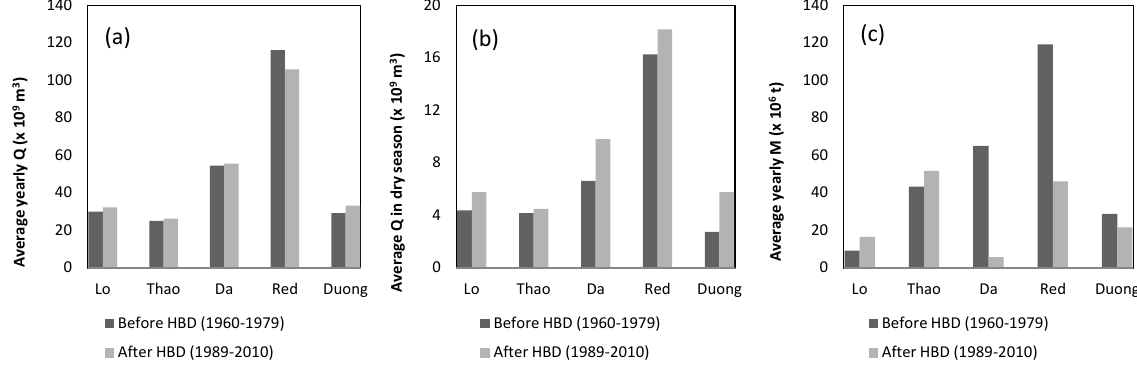
Figure 5. Change in average water and suspended sediment discharge in the main tributaries of the Red River system before and after Hoa Binh dam impoundment: (a) average yearly Q , (b) average Q in the dry season, and (c) average yearly M . Table 2. Average monthly and annual suspended sediment concentrations (mgL − 1 ), and intra-annual variability (coefficient of variation of mean monthly values) obtained from measurements at five gauging stations before (1960–1979) and after (1989–2010) Hoa Binh dam